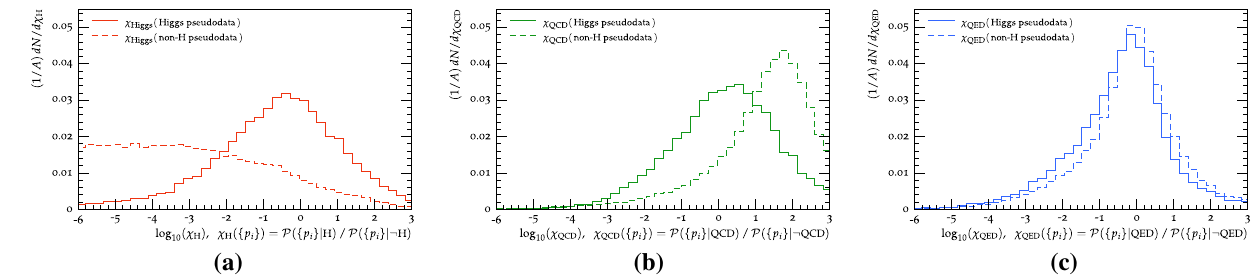
Fig. 6 Classification of signal or background pseudodata according to different signal hypotheses. a Higgs hypothesis χ H ( (cid:8) H = 0 . 1 GeV), b QCD hypothesis χ QCD , c QED hypothesis χ